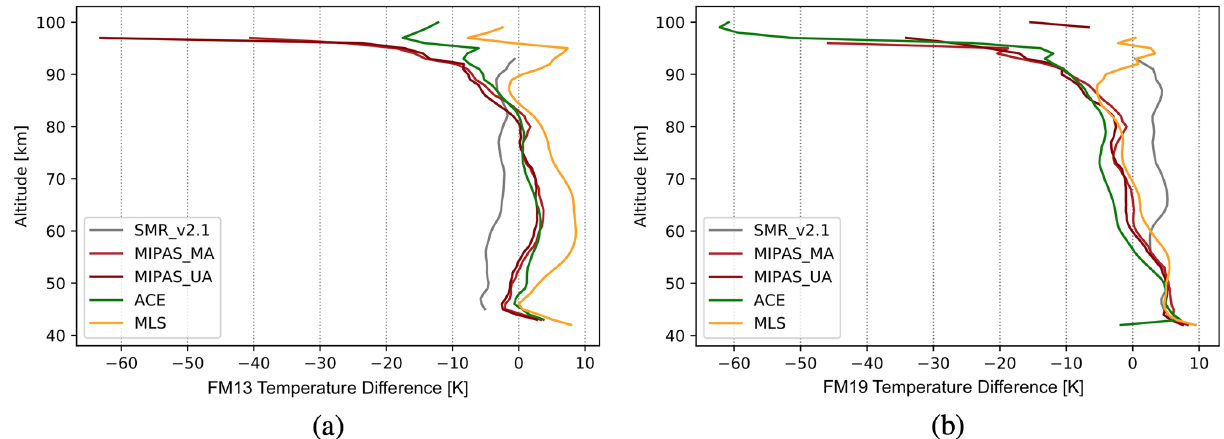
Figure 13. Summary of absolute differences of SMR v3.0 temperatures with respect to SMR v2.1 ones as well as those retrieved from measurements by all other instruments considered in this study. For the sake of clarity, errors are not shown. (a) FM13 comparison. (b) FM19